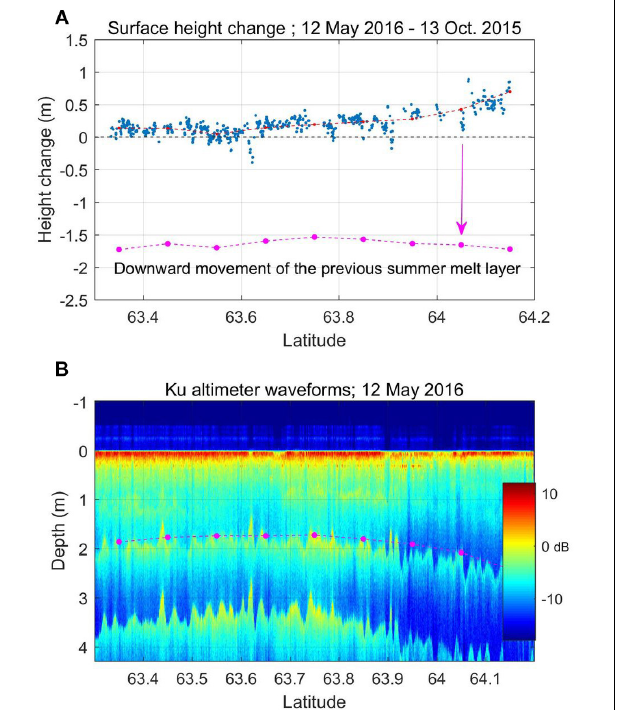
FIGURE 9 | (A) The small surface height increase from October 13, 2015 to May 12, 2016 has been derived from the repeat airborne laser scanner data along part of flight line CD in Figure 8 and is shown as blue dots. The approximate position of the last-summer melt layer with respect to the October 13, 2015 surface is plotted as a dashed magenta line. (B) The pseudo image of the May 2016 Ku-band airborne Ku-band altimeter data shows the last summer melt layers from both 2014 and 2015. The dashed magenta line indicates the approximate depth of the 2015 last-summer layer which was used in estimating the approximate downward movement of the 2015 melt